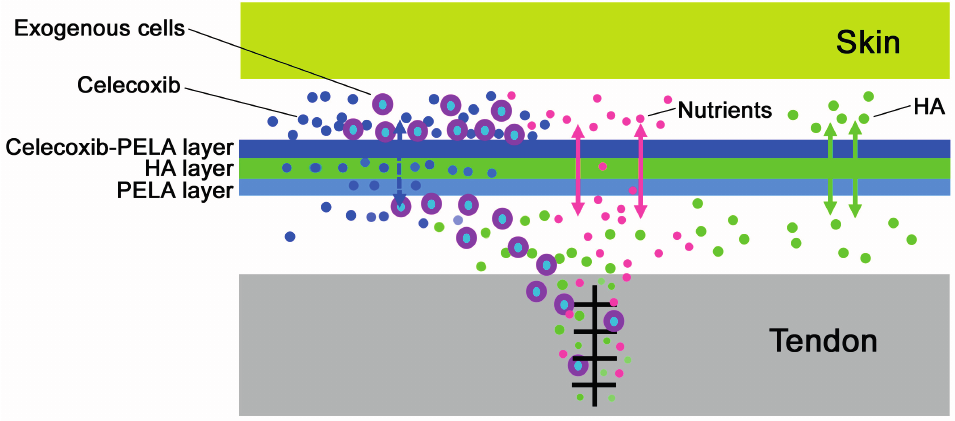
Figure 5. Schematic illustration of multi-layer membrane as physical barrier for preventing tendon adhesions after tendon